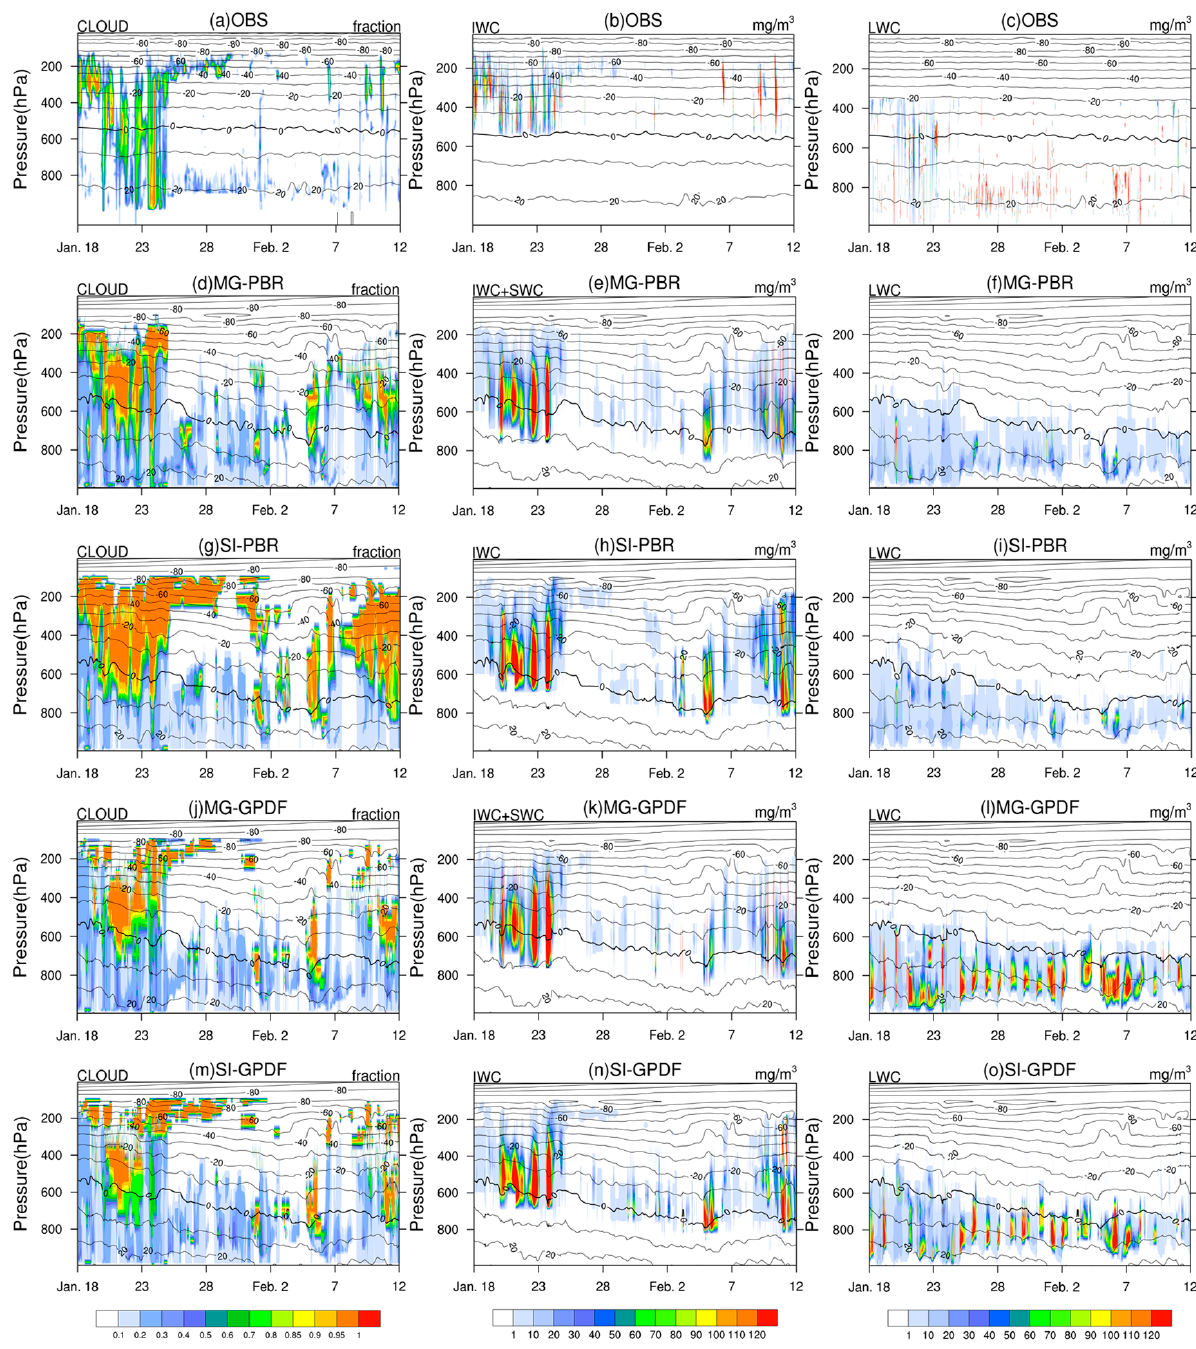
Figure 1. Temporal-vertical plot of cloud fraction (left), ice water content (middle column) and liquid water content (right) in addition to the atmospheric temperature (solid, °C) in the MG-PBR ( d – f ), SI-PBR ( g – i ), MG-GPDF ( j – l ), and SI-GPDF ( m – o ) simulation of the TWP-ICE in comparison with the observations and retrievals ( a – c ). The melting level is marked with bold lines in the middle panels.